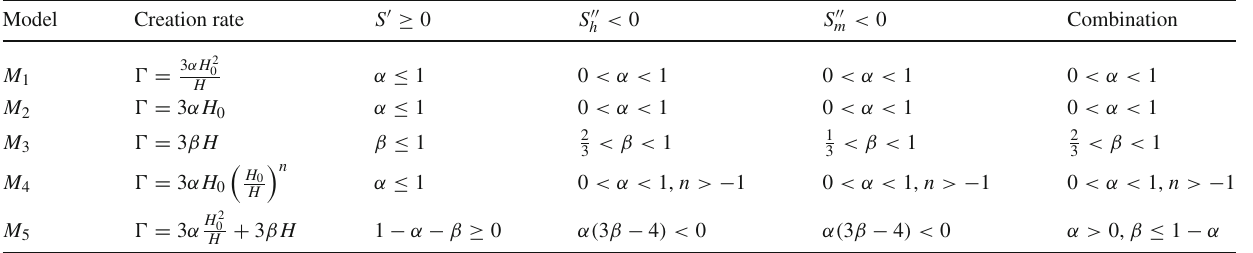
Table 2 Thermodynamic constraints on free parameters of matter creation models